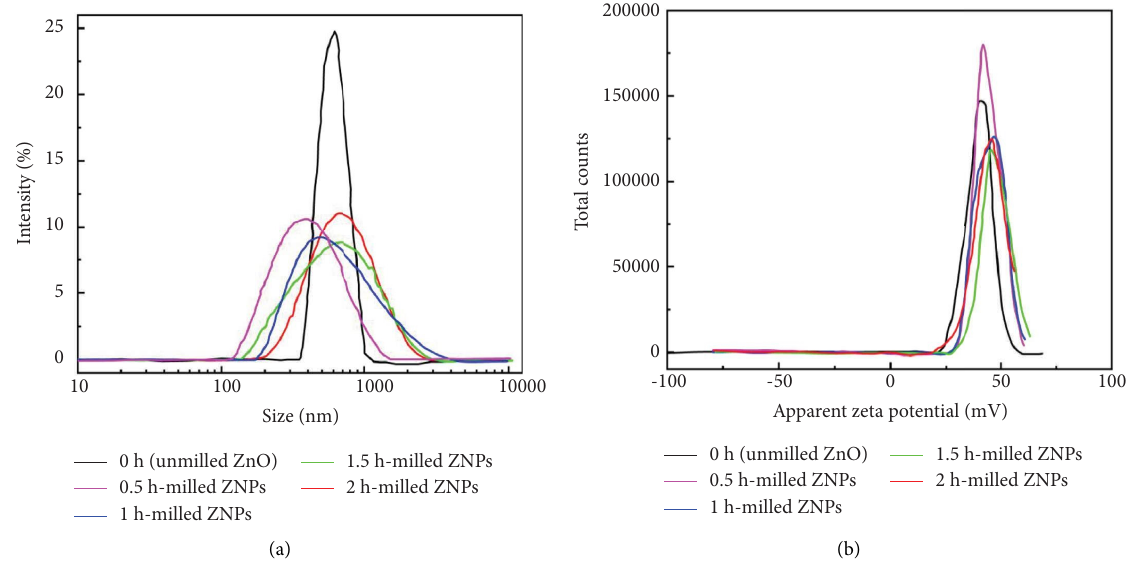
Figure 7: (a) ZnO size dependence, and (b) zeta potential dependence on milling time. Table 2: PDI of diferent studied samples. Milling time